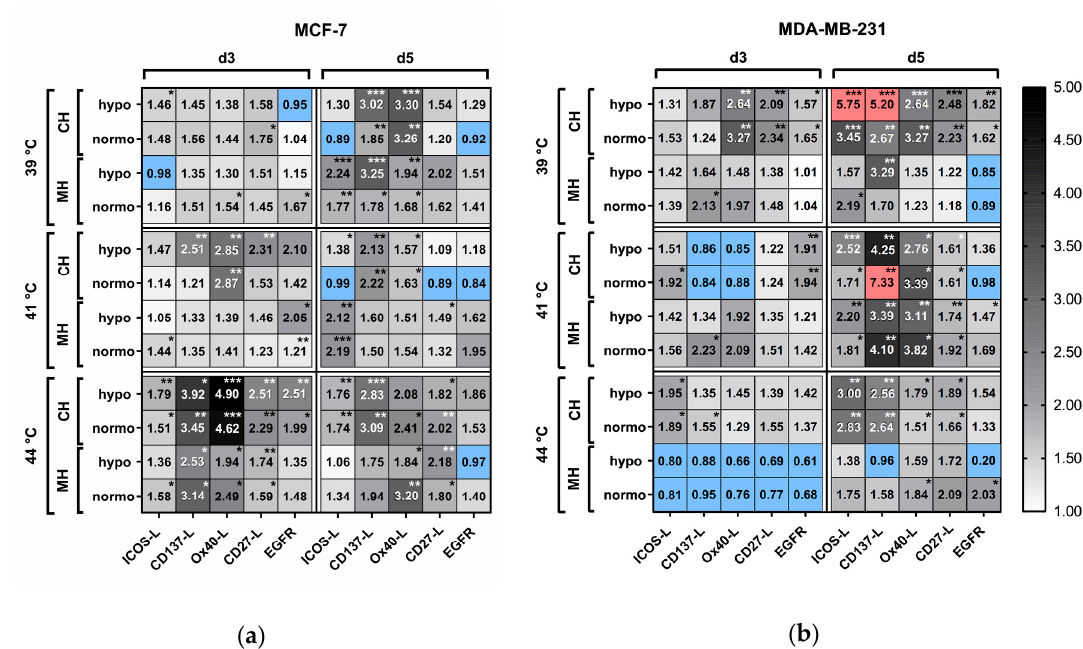
Figure 11. Heatmap of normalized expression (change in mean fluorescence intensity compared to mock-treated cells) of immune stimulatory checkpoint molecules and EGFR on the cell surface of ( a ) MCF-7 and ( b ) MDA-MB-231 breast cancer cells after combinatory treatment of conventional warm-water (CH) or microwave heating (MH) and radiotherapy. Cells were heated either by CH or MH within the self-designed hyperthermia system to three clinically relevant temperatures, i.e., 39 °C, 41 °C and 44 °C, for an effective time of 60 min. Afterwards, the cells were distributed into 75 cm 2 T-flasks for additional treatment, i.e., by normofractionated (normo) RT at single doses of 2 Gy or by hypofractionated (hypo) RT at single doses of 5 Gy, and analysis on d3 and d5. Significance test was conducted using Kruskal-Wallis test with uncorrected Dunn´s multiple comparison from three independent experiments, each measured in duplicates. * ( p < 0.1), ** ( p < 0.01), *** ( p < 0.001).